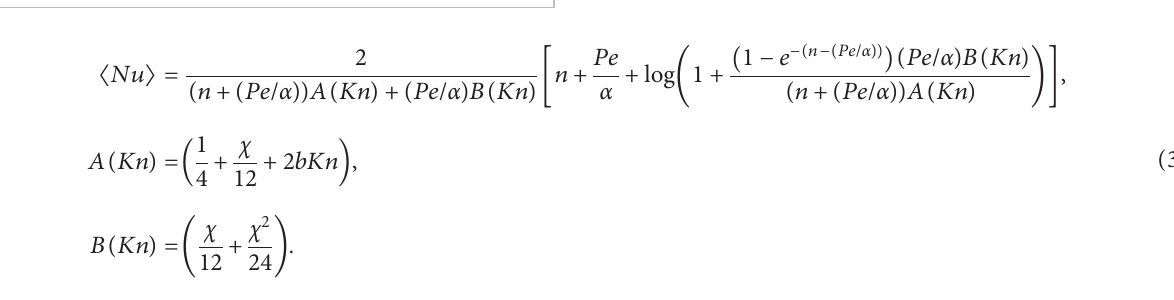
Figure 11: 〈 Nu 〉 versus Pe / α for q ( ζ ) � ( ne − n ζ ) / ( 1 − e − n ) . No viscous dissipation Br � 0. The arrow indicates increasing values of n . n � 0 w (black broken line) corresponds to a constant function q w ( ζ ) � 1. The blue curves correspond to increasing wall heat flux. The red curves correspond to decreasing wall heat flux. (a) Kn � 0; (b) Kn � 0 .